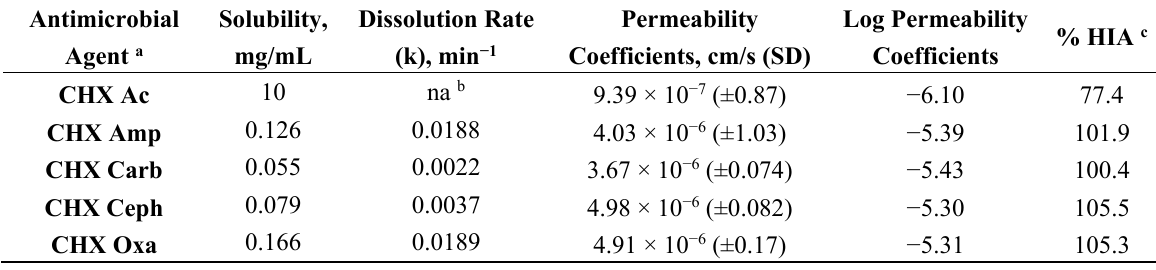
Table 2. Summary of aqueous solubility, pharmacokinetic properties and intestinal bioavailability for β-lactam-based chlorhexidine GUMBOS.